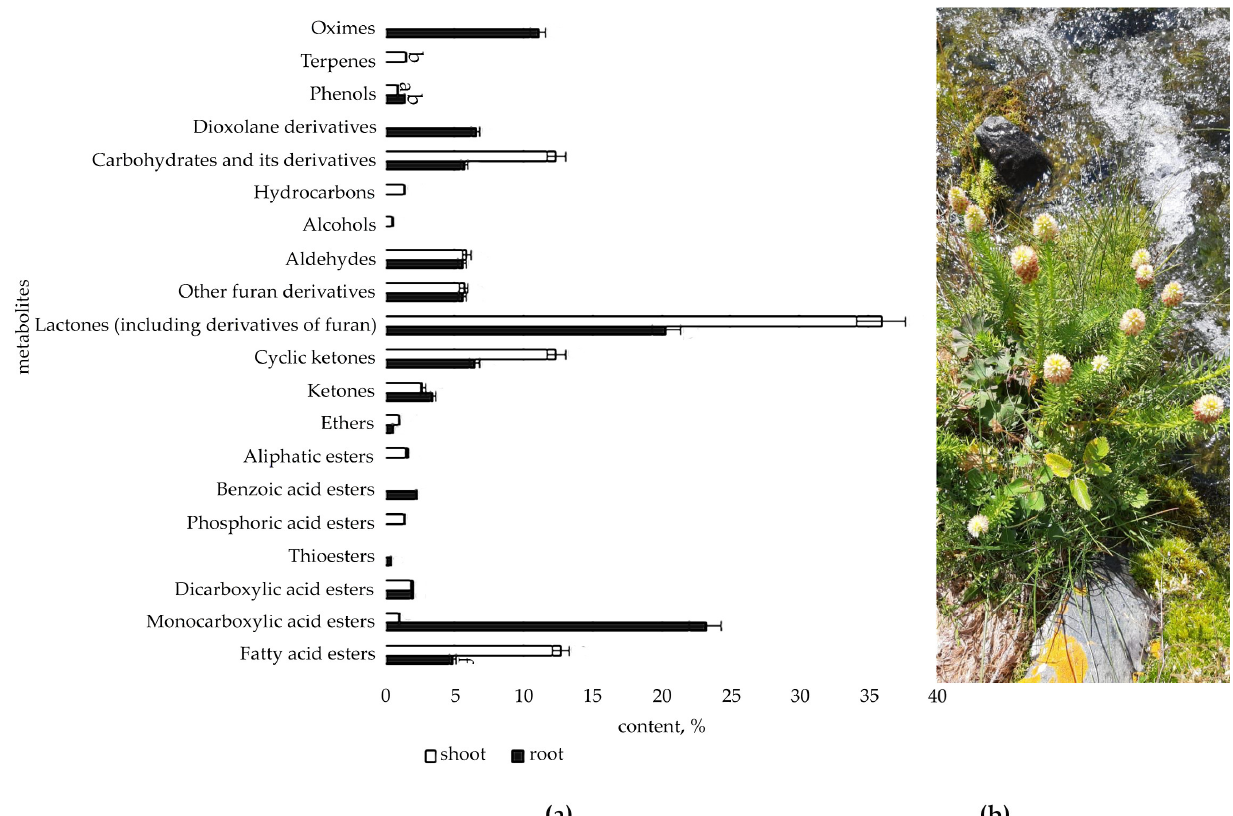
Figure 2. ( a ) Content of secondary metabolites classes in root and shoot of flowering plants R. semenovii , %. Values presented are means ( ± SD). Different letters above the bars represent signifi- cant differences at p ≤ 0.05, n = 3 plants in each of 3 replicates for all treatments; ( b ) flowering plants R. semenovii